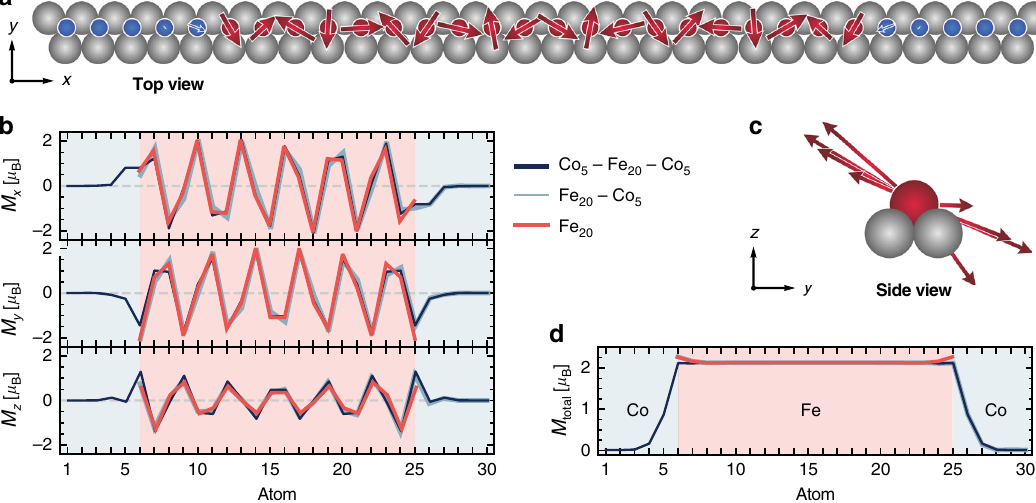
Fig. 3 Calculated spin structure of the Fe 20 chain without and with Co 5 termination. a Top view of the calculated spin structure in the Co 5 – Fe 20 – Co 5 chain. Blue and red spheres correspond to Co and Fe atoms, respectively. The length of the arrows is proportional to the size of the in-plane component of the magnetic moment at each particular site. b x , y , and z components of the magnetic moments in the Co 5 – Fe 20 – Co 5 -, the Fe 20 – Co 5 -, and the Fe 20 chains. c Side view of the Co 5 – Fe 20 – Co 5 chain cycloidal spin spiral along the negative x direction. d Total magnetic moment of the atoms along all three